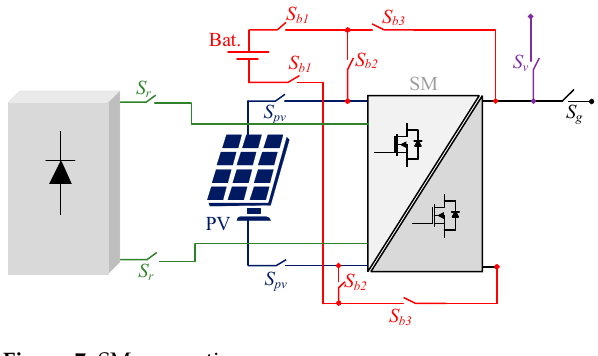
Figure 7. SM connection. Table 1. Modes of operation versus the relay’s status.